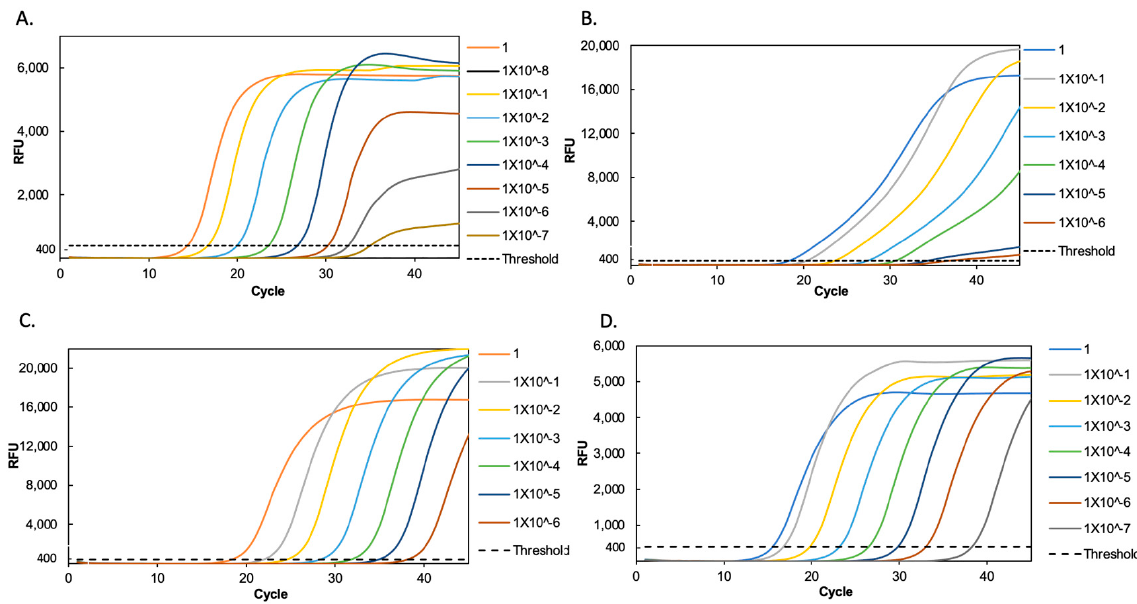
Figure 1. Amplification curves of RT-qPCR for the different assays. ( A ) E marker in triplex RT-qPCR, ( B ) RdRp marker in triplex RT-qPCR, ( C ) RdRp marker in duplex RT-qPCR, and ( D ) E marker in duplex RT-qPCR, all for different dilutions of viral RNA from a SARS-CoV-2 positive sample.